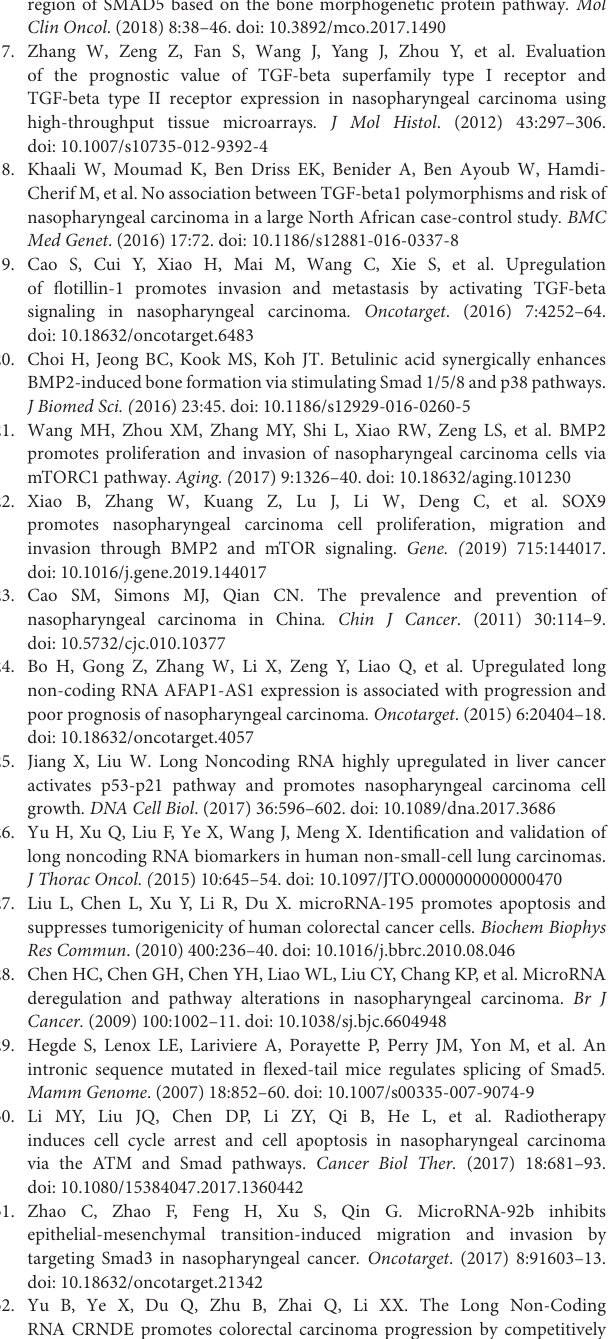
Independent sample t -test was adopted to compare data between two groups. The experiment was repeated 3 times. Supplementary Figure 5 | Silencing of SMAD5-AS1 or miR-195 overexpression impeded CNE-1 cell growth and migration via blocking the BMP2/SMAD5 pathway. (A) The expression of BMP2, miR-195, SMAD5, and SMAD5-AS1 in CNE-1 cells determined using RT-qPCR. (B) The protein expression of BMP2 and phosphorylated SMAD5 in CNE-1 cells measured using western blot analysis. (C)